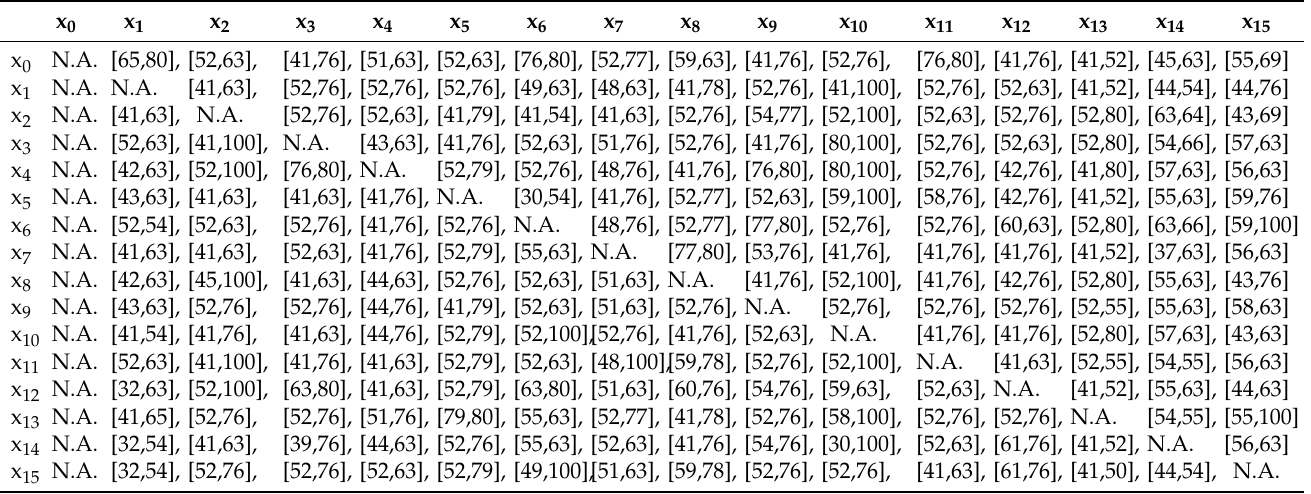
Table A1. Fuzzy costs for the objective O 1 .